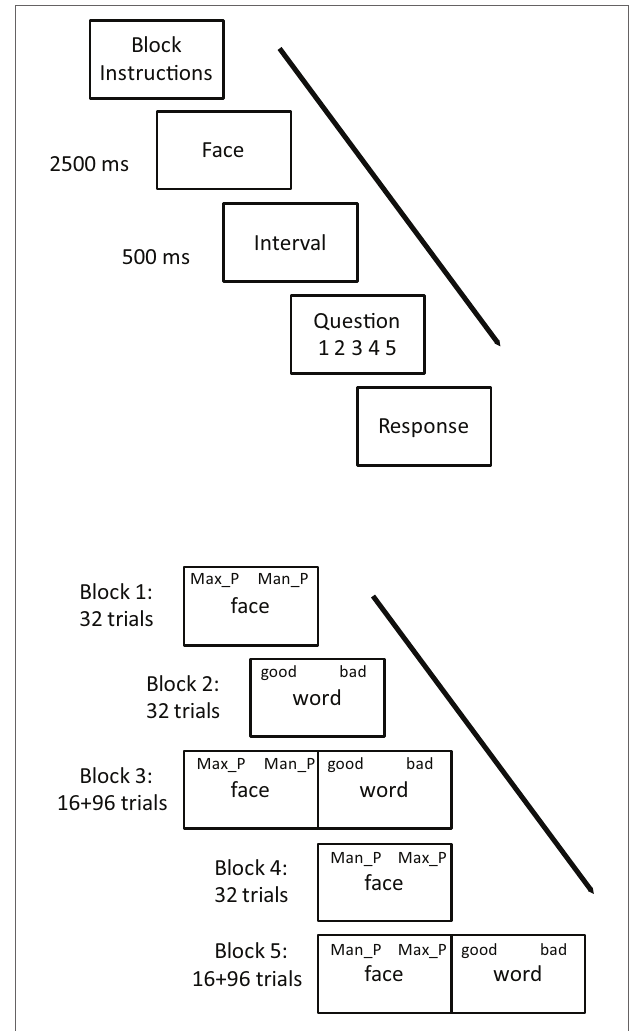
FIGURE 2 | The experimental procedure for: (A) Experiment 1, where participants evaluate if faces are smiling in one block of trials, and happy in another block of trials, presented in counterbalanced order across participants; and (B) Experiments 2 and 3, using the Implicit Association Test (IAT) task. Max_P means maxillary protrusion; Man_P means mandibular protrusion. Participants responded in the IAT task using a computer keyboard, using the “f” and “j” keys to categorize face displays as Max_P vs. Man_P and word displays as “good” vs. “bad.” In Block 1, participants categorized faces only, in Block 2 they categorized words only, in Block 3 they categorized faces and words on 50% of trials each, in Block 4 they categorized faces only and, finally, in Block 5 they categorized faces and words on 50% of trials each. Half of the participants used the “f” key for Max_P responses in Blocks 1 and 3 and Man_P responses in Blocks 4 and 5, whereas the other half used this key for Man_P responses in Blocks 1 and 3 and for Max_P responses in Blocks 4 and 5. All participants used the “f” key for good responses in Blocks 2, 3, and